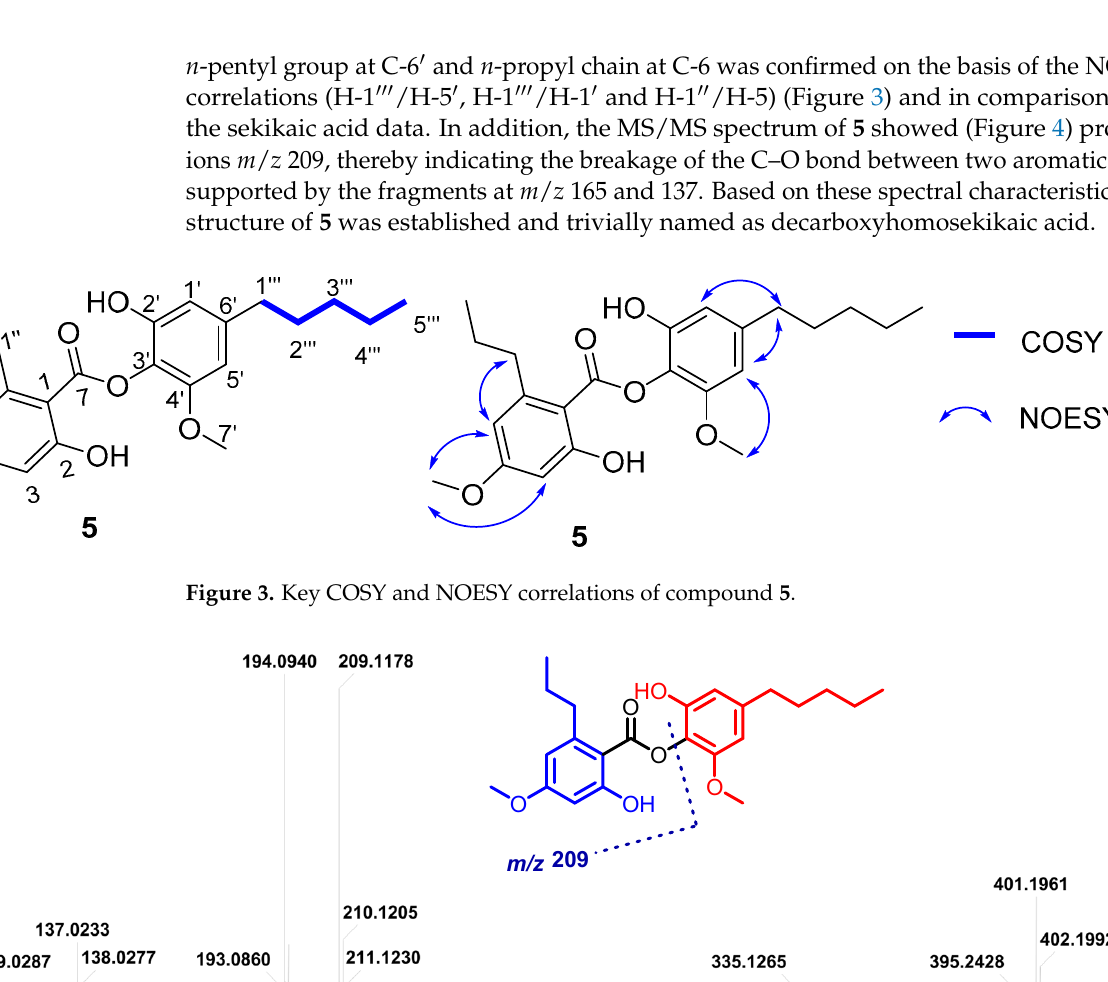
Figure 4. MS/MS spectrum and proposed fragmentation of compound 5 .